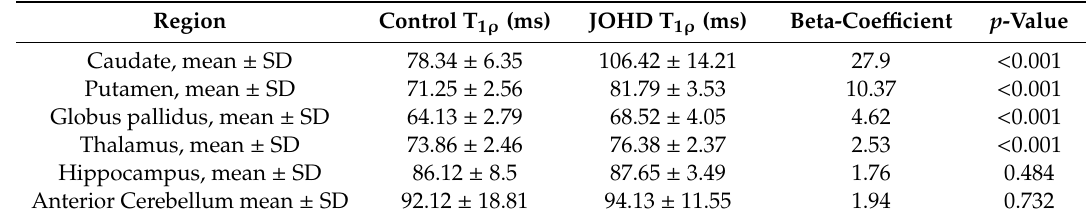
Table 2. Regional T 1 ρ relaxation times—juvenile-onset Huntington’s disease (JOHD) participants. Region